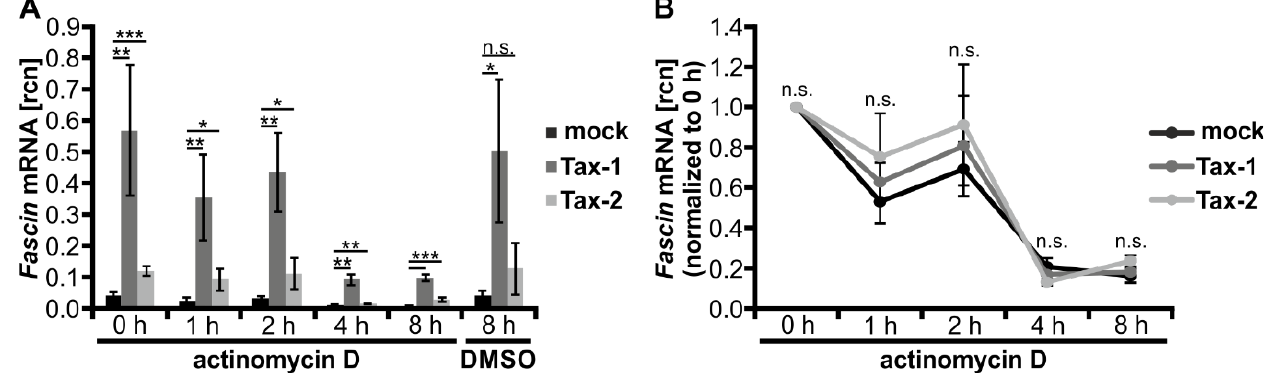
Figure 3. Tax-1 and Tax-2 do not stabilize Fascin transcripts. ( A , B ) Jurkat T-cells were